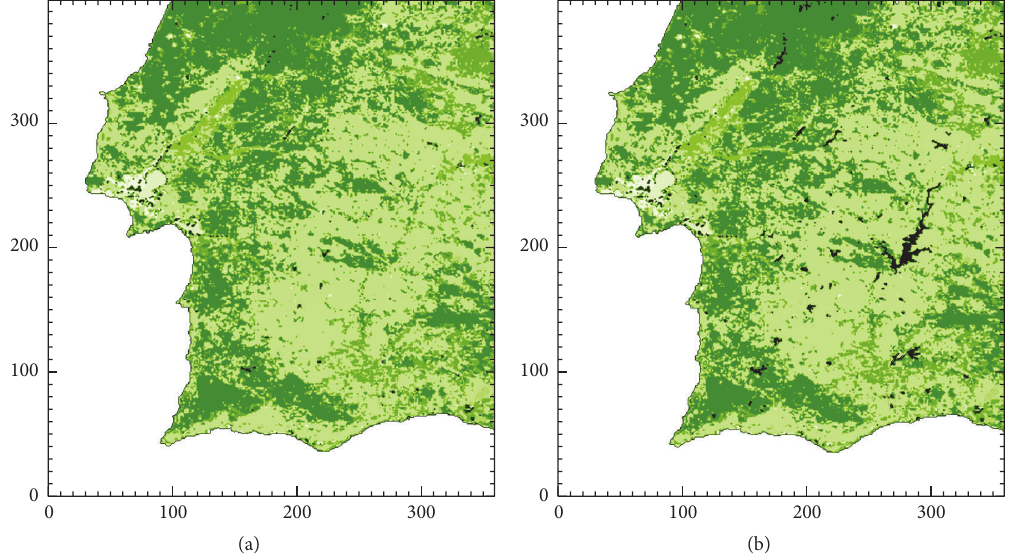
Figure4:ECOCLIMAPv2.0database:(a)originaland(b)changed.Greencolors(meannature)andblackcolors(meansurfacewaterbodies). Axis coordinates are in